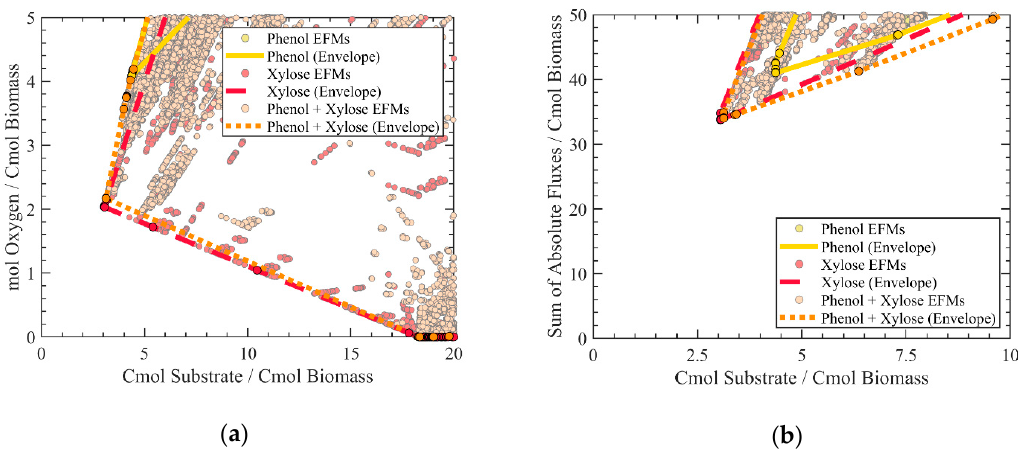
Figure 4. Xylose and phenol co-metabolism (phenol in yellow; xylose in red; co-utilization in